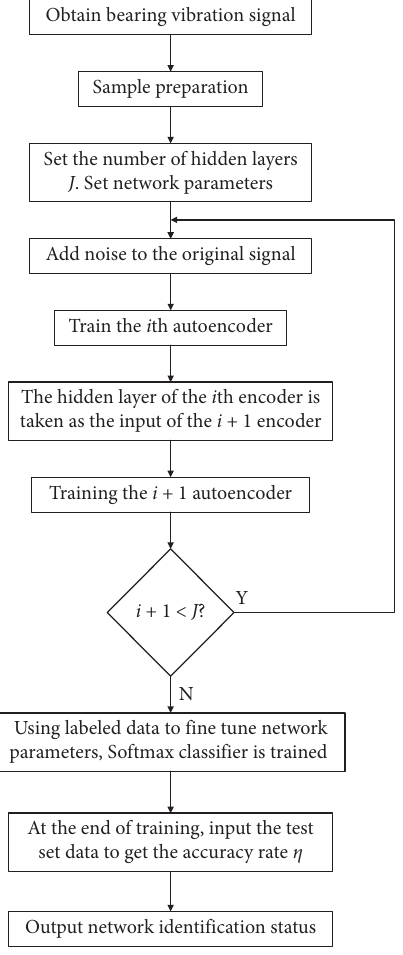
Figure 7: Improved SDAE network